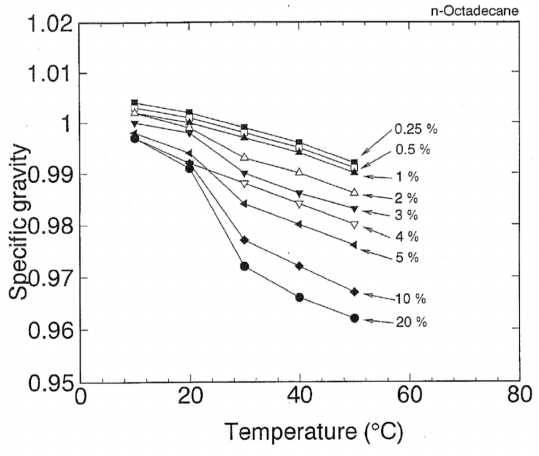
Figure 2. Relationship between the specific gravity and temperature of the suspension